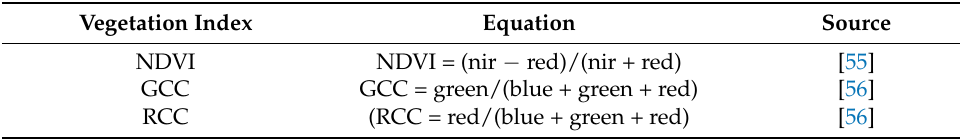
Table 3. Equations of vegetation indices